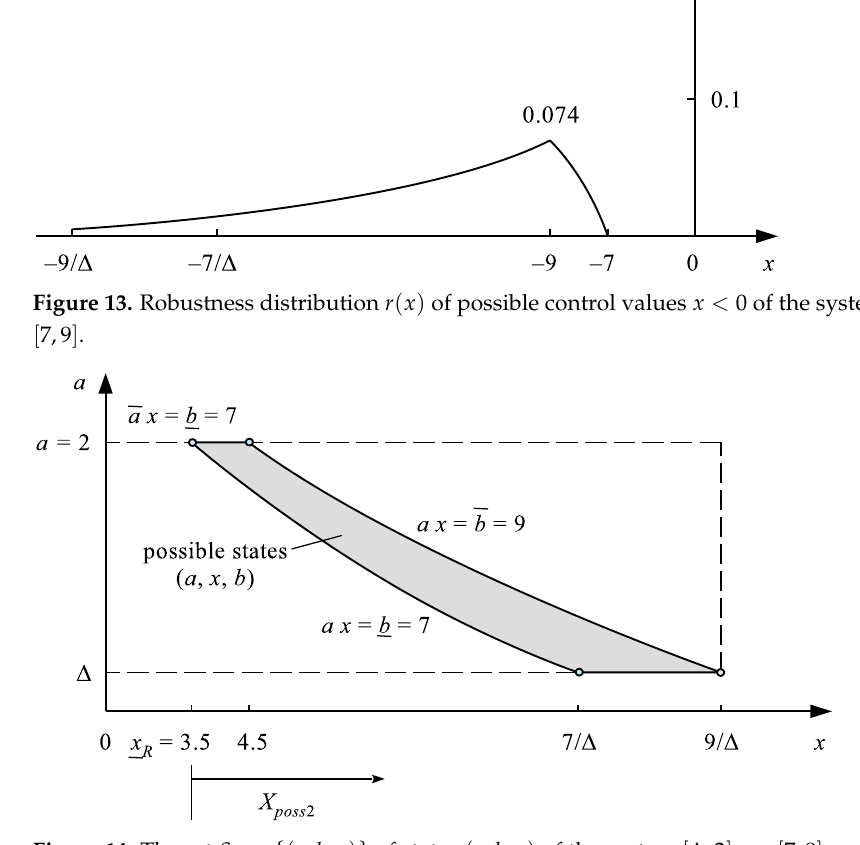
Figure 14. The set S 2 = { ( a , b , x ) } of states ( a , b , x ) of the system [ ∆ ,2 ] x = [ 7,9 ] enabling tolerance control for x >